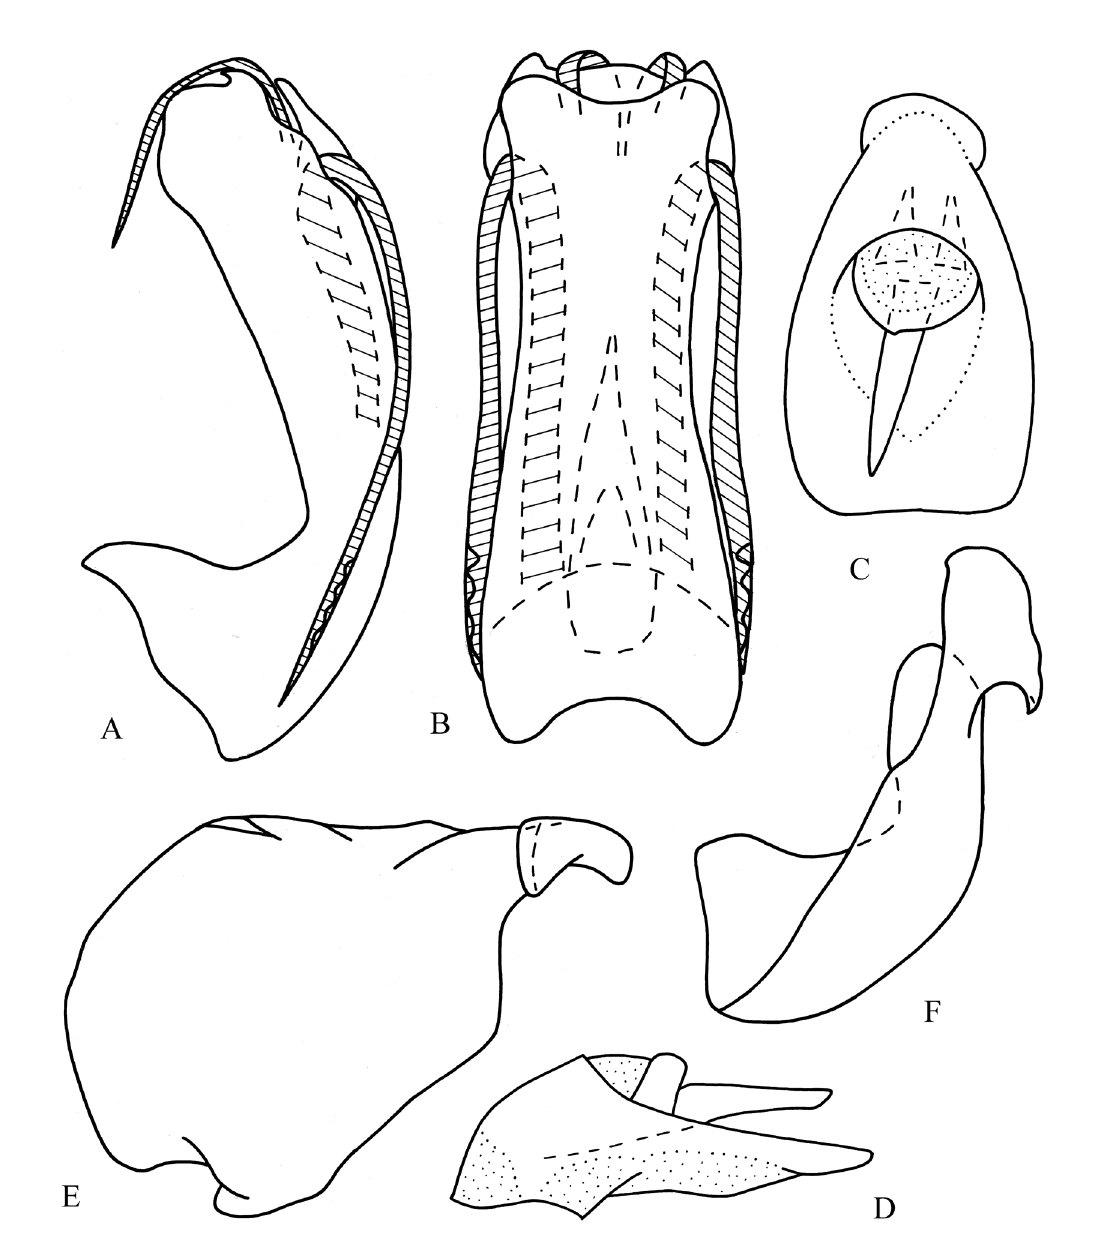
Fig. 7. Superciliaris tawaiensis sp. nov., ♂, holotype (BMNH), genitalia. A . Penis, lateral view. B . Penis, ventral view. C . Anal tube, dorsal view. D . Anal tube, lateral view. E . Style, lateral view. F . Style, dorsal view. No to